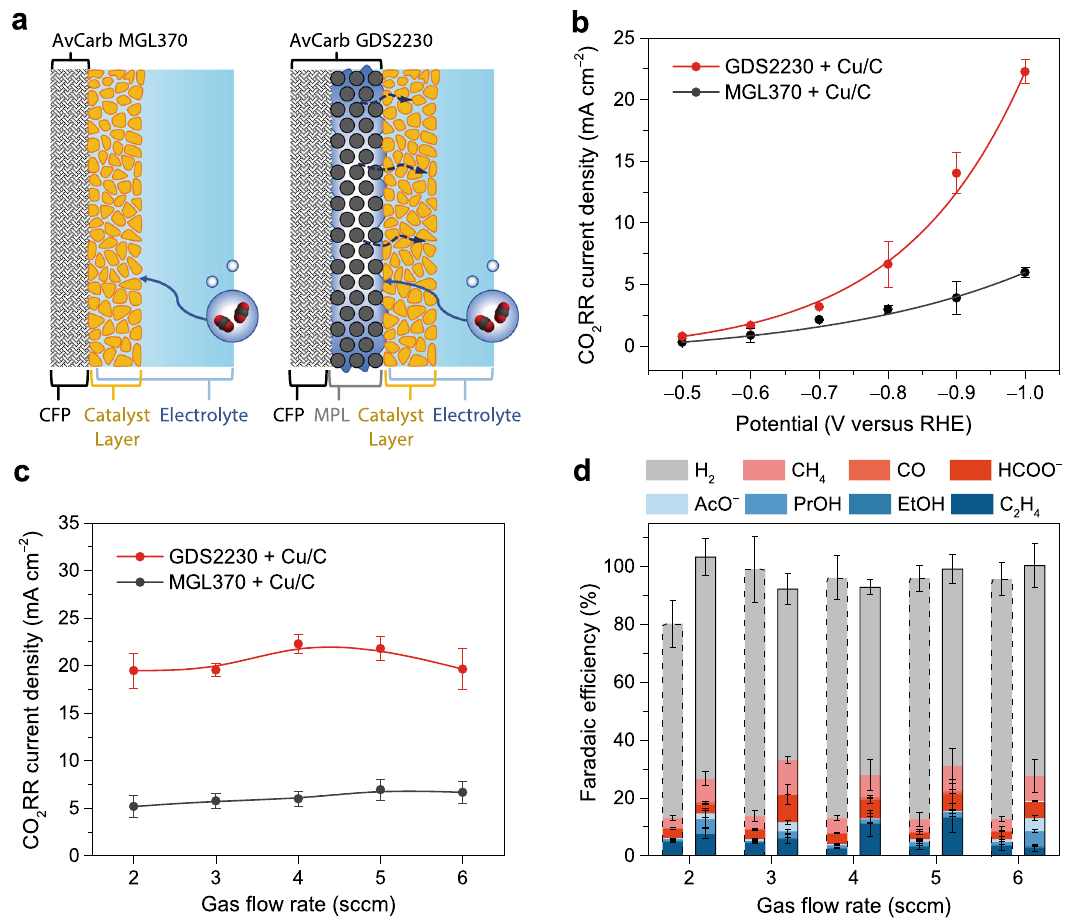
Fig. 2 Effect of hydrophobic substrate on the CO 2 RR in H-cell. a Con fi gurations of the two electrodes prepared with AvCarb MGL370 and GDS2230 substrates. b Partial current densities for CO 2 RR on the two electrodes at various potentials with a CO 2 gas fl ow rate of 4 sccm. c Partial current densities and d Faradaic ef fi ciencies for CO 2 RR on the two electrodes at − 1.0 V with various CO 2 fl ow rates. In d , the left column with dashed line frame at each fl ow rate is for the AvCarb MGL370 + Cu/C electrode, and the right column with solid line frame is for the AvCarb GDS2230 + Cu/C electrode. The error bars represent the standard deviation of three independent